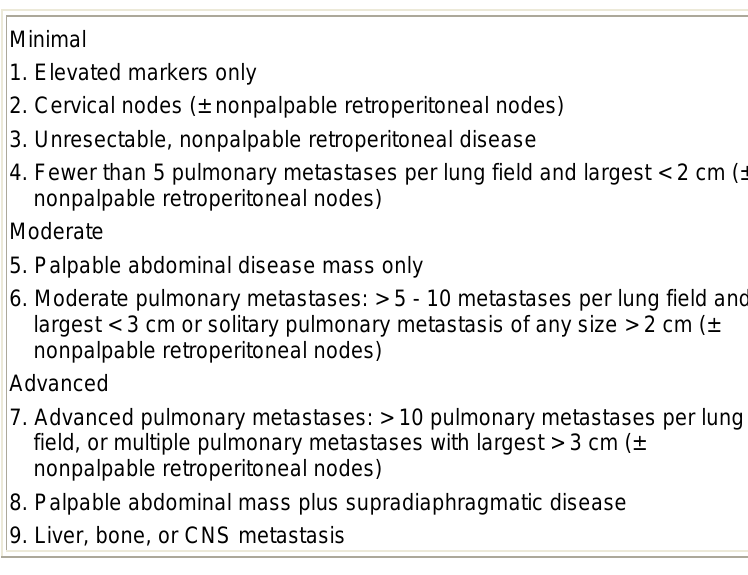
INDIANA UNIVERSITY STAGING SYSTEM FOR DISSEMINATED DISEASE: MINIMAL AND MODERATE STAGES CONSTITUTE GOOD RISK